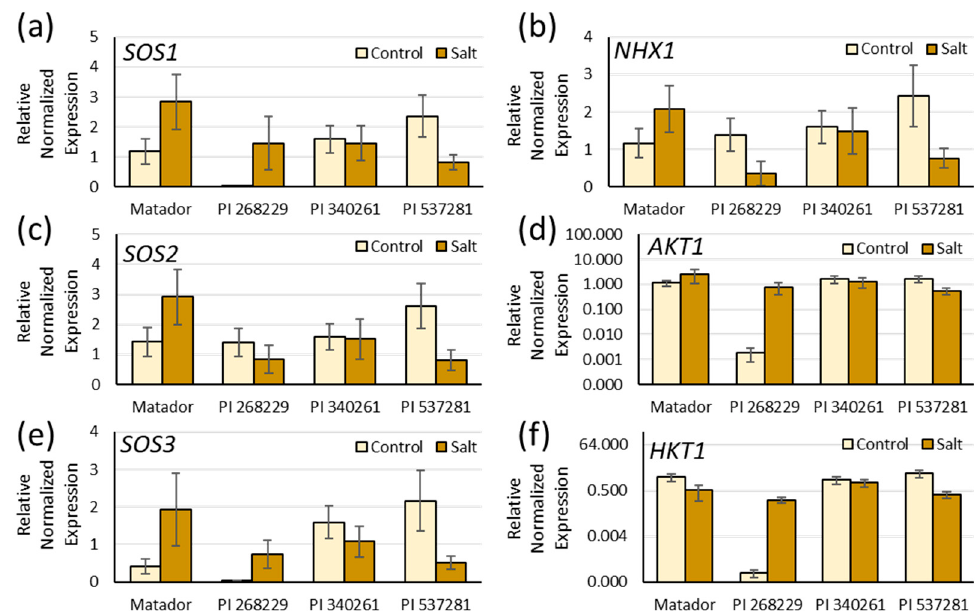
Figure 4. Expression of genes involved in Na + transport in the roots of the four guar genotypes irrigated with control and saline irrigation waters ( n = 3). ( a ) SOS1 . ( b ) NHX1 . ( c ) SOS2 . ( d ) AKT1 . ( e ) SOS3 . ( f ) HKT1 . Error bars represent standard errors.